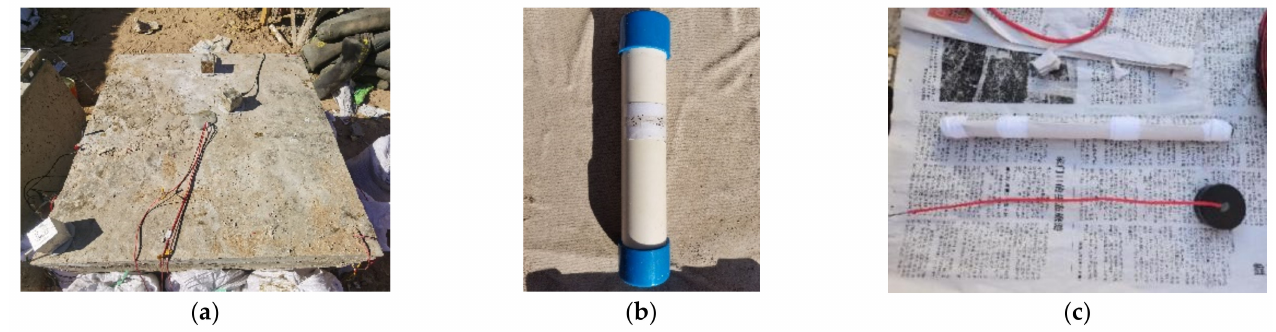
Figure 1. High-energy gas fracturing test: ( a ) Simulated coal test blocks, ( b ) Fracturing agent, ( c ) Ignition device.